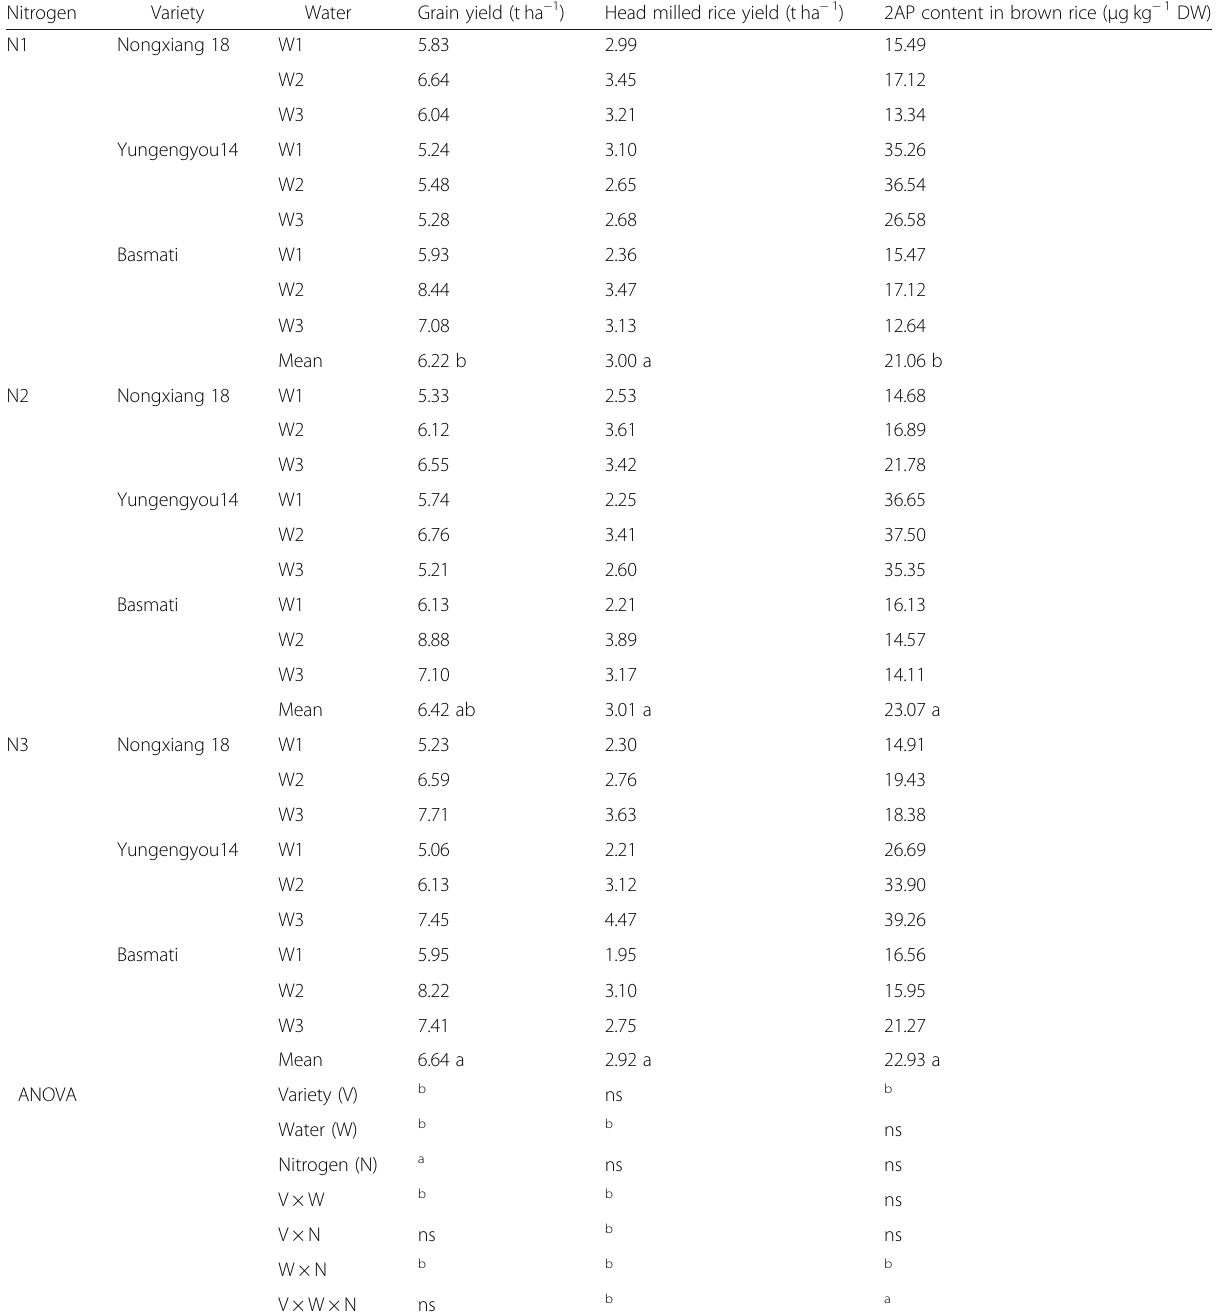
Table 3 Grain yield, head milled rice yield and 2AP content in brown rice of three fragrant rice varieties grown under different water and nitrogen treatments in early season of 2013 Nitrogen